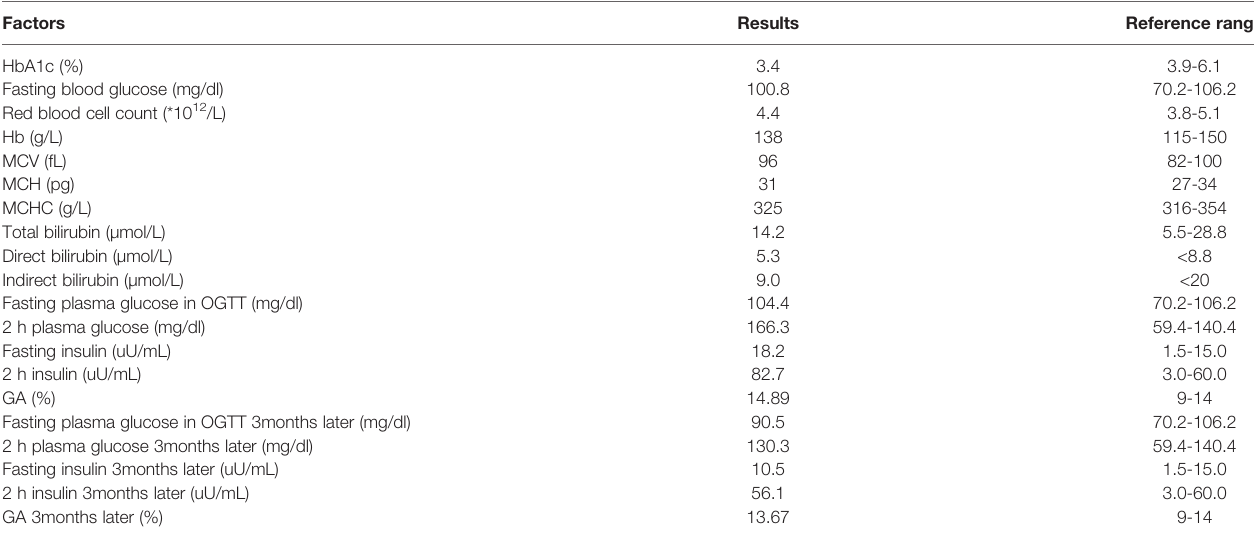
TABLE 1 | Laboratory results of the patient. Factors Results Reference